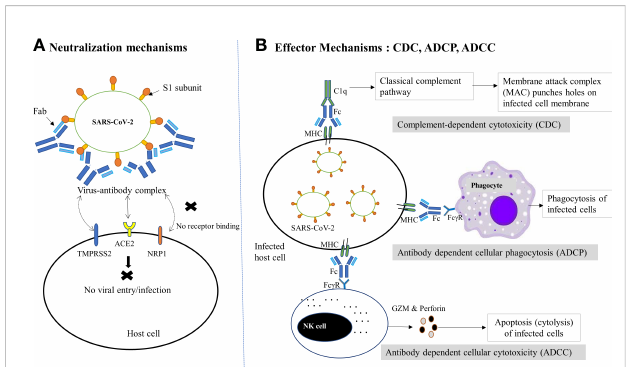
FIGURE 1 Schematic diagram of NAb-mediated protective mechanisms against SARS-CoV-2 infection. (A) Neutralization mechanisms: Following the binding of NAbs (via Fab) to the RBD of the S1 subunit of SARS-CoV-2, the virus-antibody complex is formed, which prevents the viral binding to host receptor (ACE2) or coreceptors (TMPRSS2, NRP1 etc.) or changes the conformation of the S protein to block viral entry into host cells, thereby preventing subsequent membrane fusion or infection. (B) Effector mechanisms: The binding of antibody-bound infected host cells (via MHC and Fc) to the Fc g R of the immune cells and complements (C1q) trigger several effector mechanisms to kill the virus infected cells. In the CDC pathway, complement activates the classical complement pathway and induces cell death by the formation of MAC. On the other hand, phagocytes interact with MHC and result in phagocytosis of infected cells via ADCP. Similarly, the interaction of Fc g R-expressing NK cells with the Fc of the antibody complex leads to cytotoxic granule release (GZM and perforin) and hence cytolysis (ADCC). ACE2, Angiotensin-converting enzyme 2; ADCC, Antibody-dependent cellular cytotoxicity; ADCP, Antibody- dependent cellular phagocytosis; CDC, complement-dependent cytotoxicity; Fab, fragment antigen-binding region; Fc, crystallizable fragment; Fc g R, Fc gamma receptor; GZM, Granzyme; MAC, Membrane attack complex; MHC, major histocompatibility complex; NAbs, Neutralizing antibodies; NK, Natural killer cell; NRP1, neuropilin 1;TMPRSS2, transmembrane serine protease